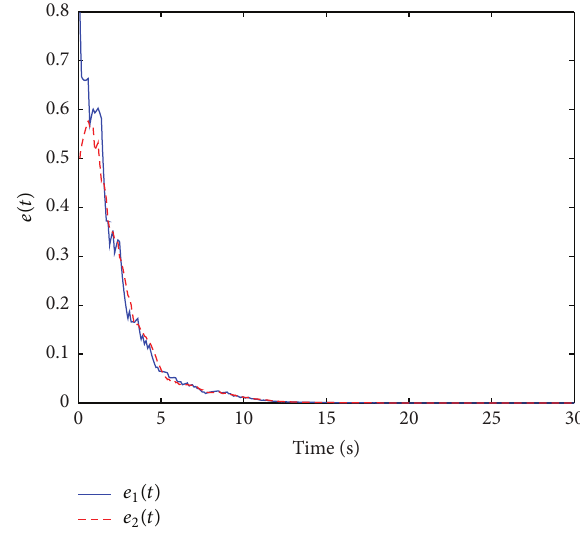
Figure 1: The simulation of system mode 𝜂 𝑡 .